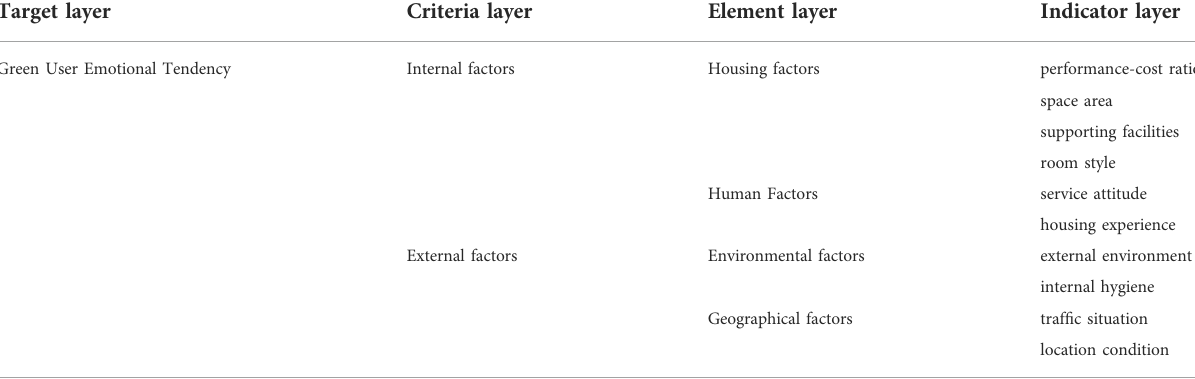
TABLE 2 Index system of green user emotion